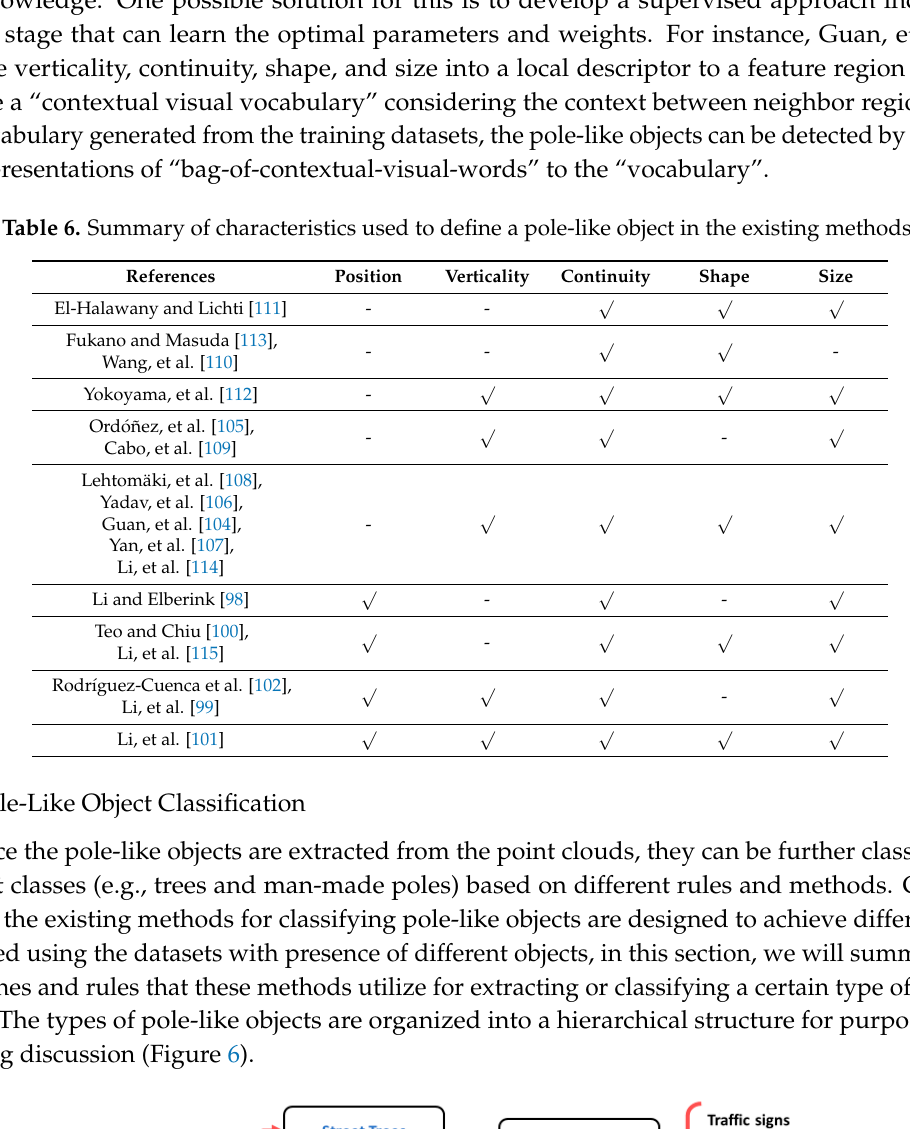
Table 6. Summary of characteristics used to define a pole-like object in the existing methods.